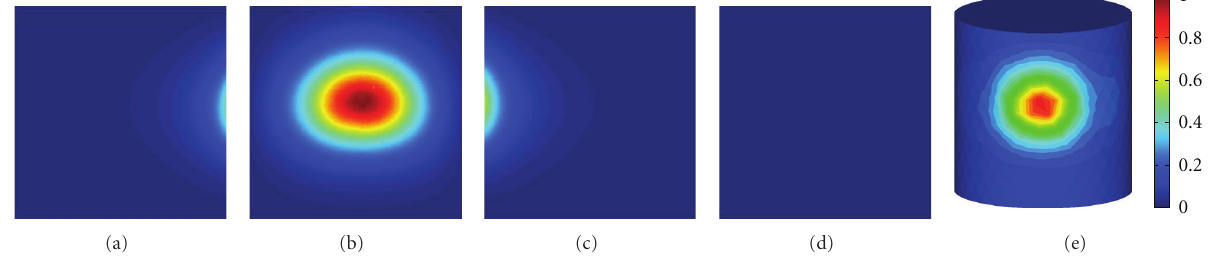
Figure 6: The normalized surface measurement of the homogeneous phantom. (a), (b), (c), and (d) are left view, front view, right view, and back view of the cylindrical phantom on the CCD camera, respectively; (e) is the flux density on the surface of the cylindrical phantom after mapping from the CCD camera.